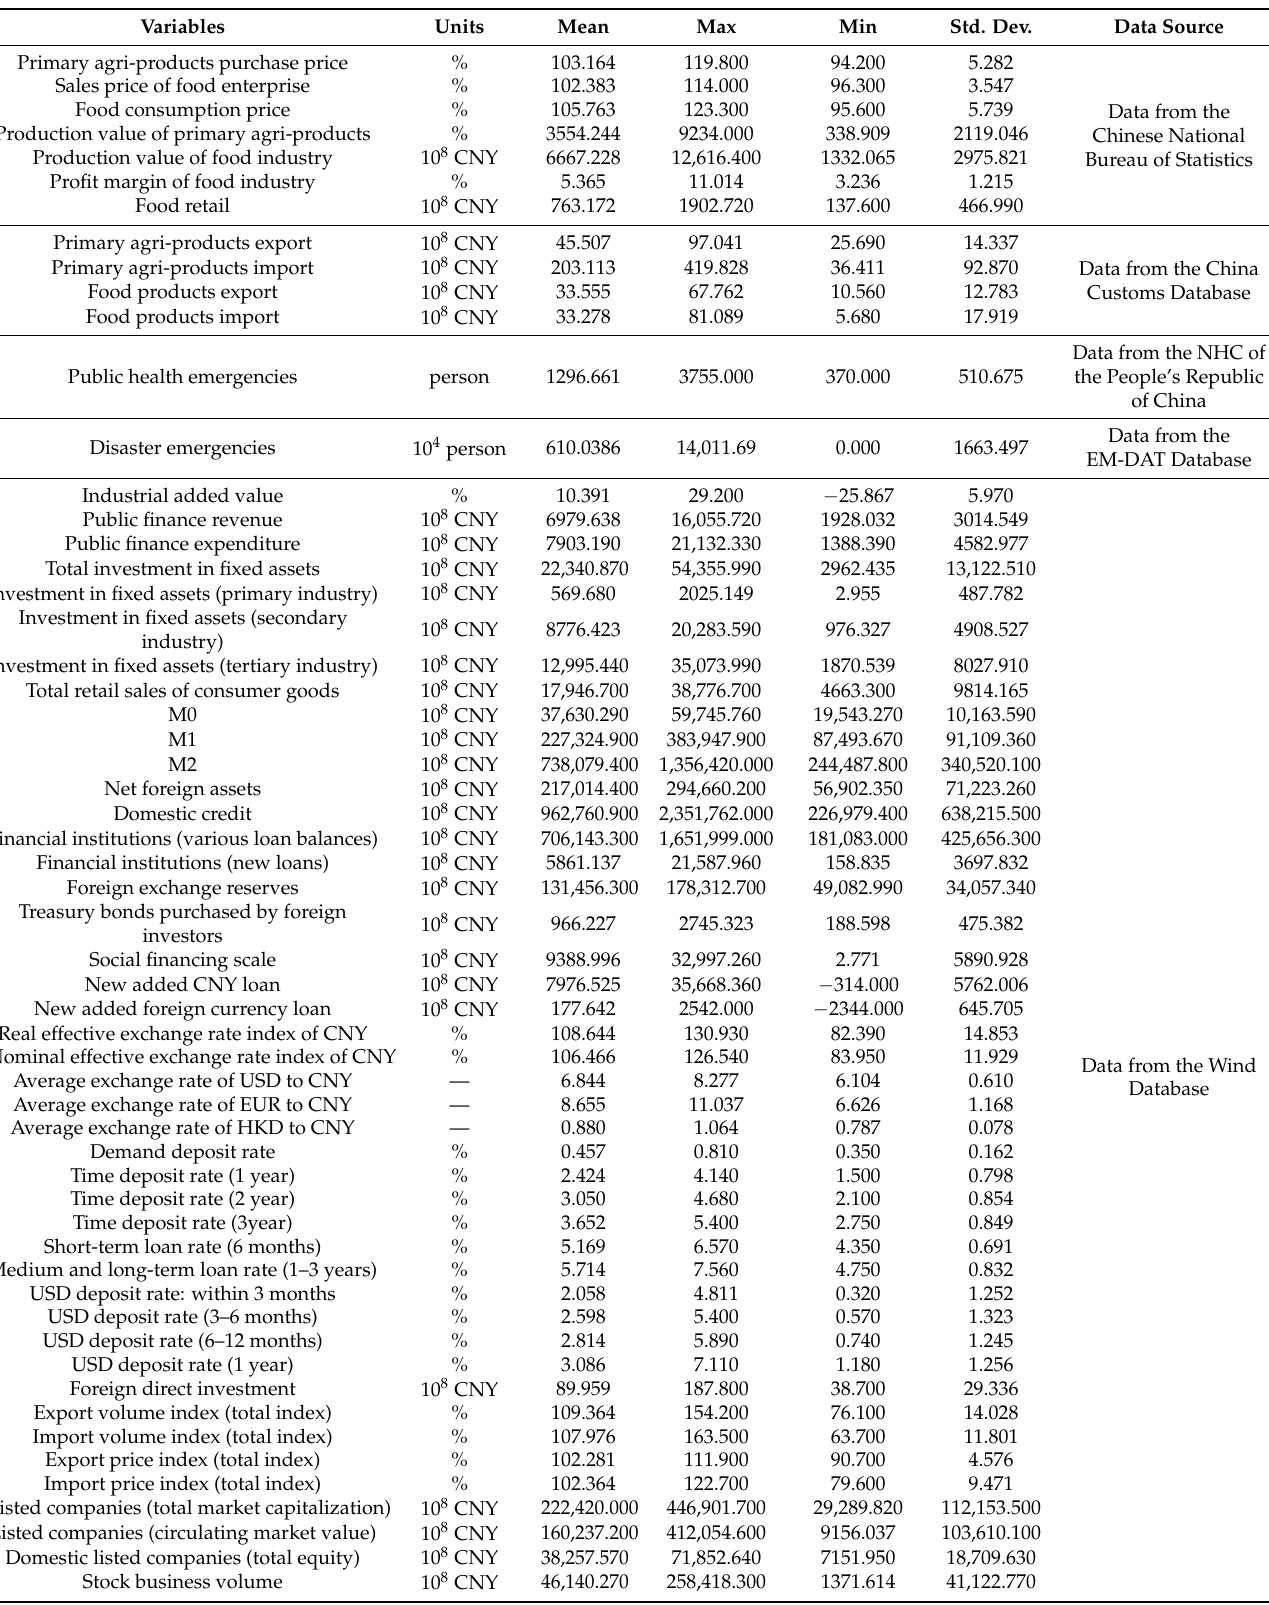
Table 1. Descriptive statistics of